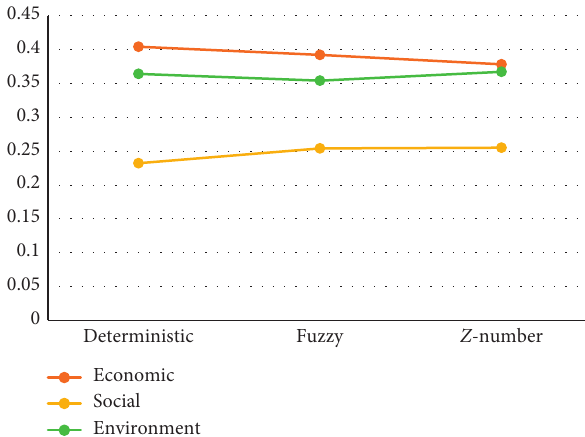
Figure 9: Comparison of importance weights of sustainability dimensions under different scenarios (in terms of quantity and ranking).